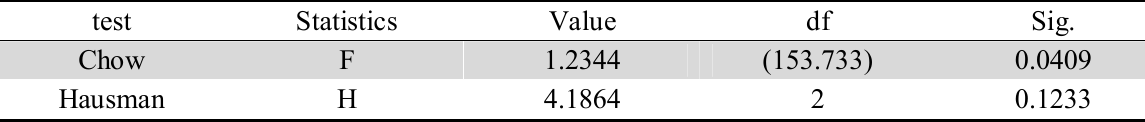
The summary of Chow and Hausman